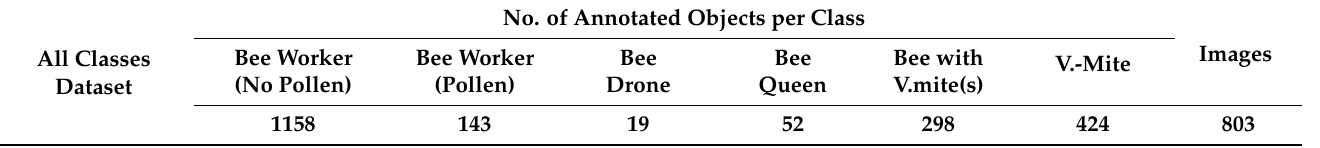
Table 1. The table shows the number of annotated objects of given